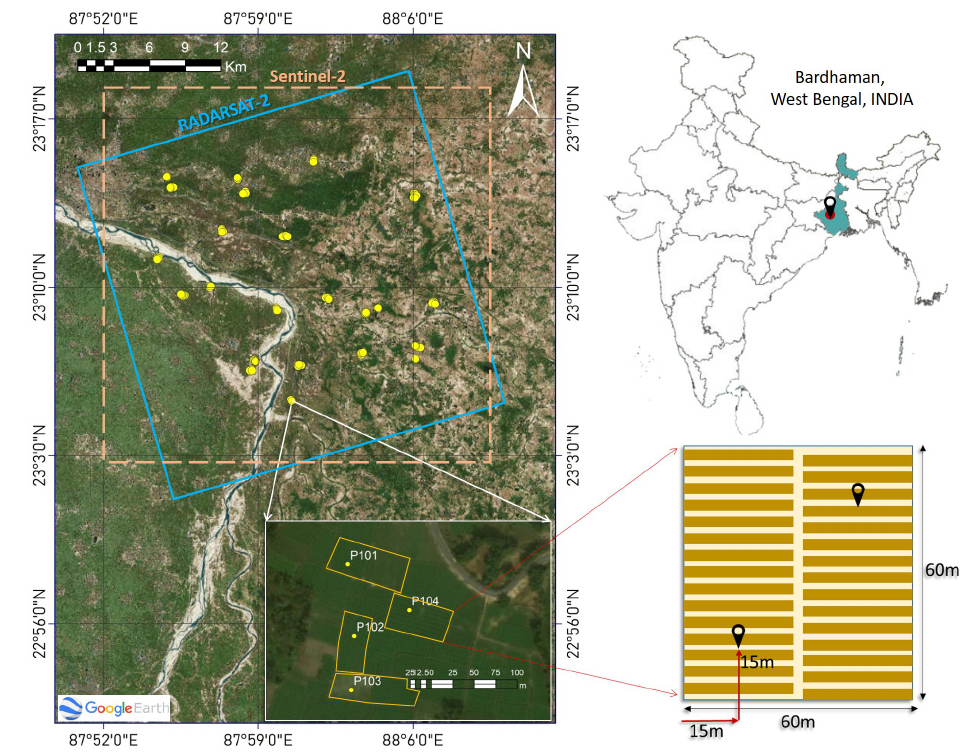
Figure 1. Test site with sampling locations.The cyan and light brown box defines the RADARSAT-2 and subset of Sentinel-2 coverage, respectively.